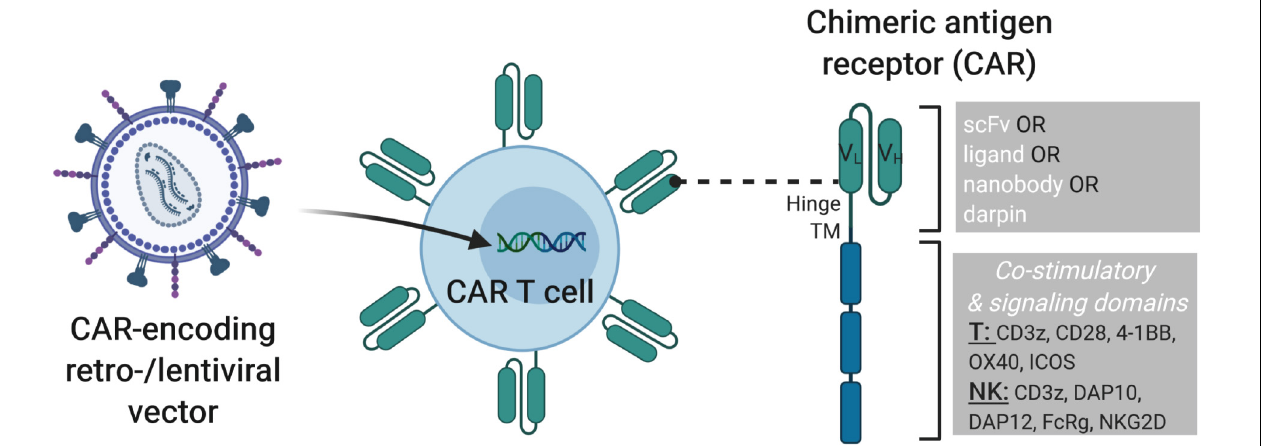
FIGURE 1 | Modification of T or NK cells with CAR-encoding retro- and lentiviral vectors. On the left, a lentiviral vector is shown that transfers the genetic cargo into the T or NK cells leading to the expression of a chimeric antigen receptor (CAR) on the cell surface. On the right, the structure of a 3 rd generation CAR is depicted with single chain variable fragment (scFv, including V H and V L chains), hinge, transmembrane and signaling domains shown. CARs can be engineered with cell-type specific modules to enhance CAR T or CAR NK cell activity. Examples of cytoplasmic signaling domains that can be engineered into CARs for T and NK cells are shown. Combining such strategies with additional genome modification approaches described in later sections of this review will lead to improved “off-the-shelf” cell